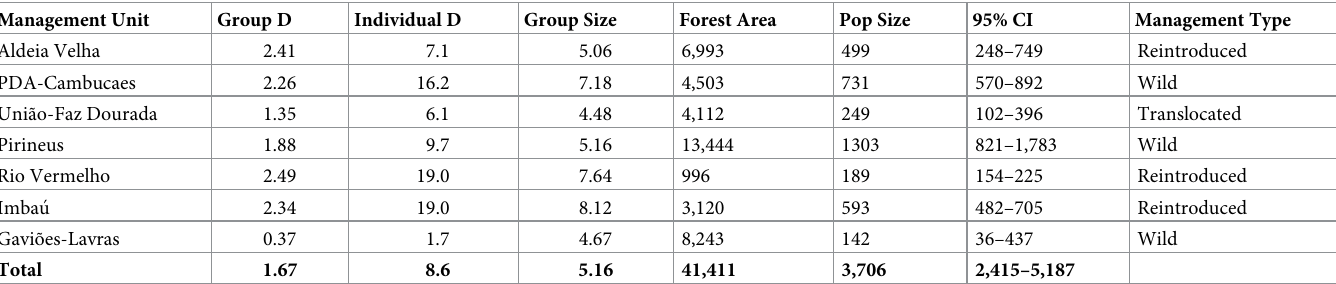
observed group densities were multiplied by the average group size observed during the sur- veys for each point with detections (Table 2). Using this method, we estimate the total number Table 2. Results of the playback survey for each management